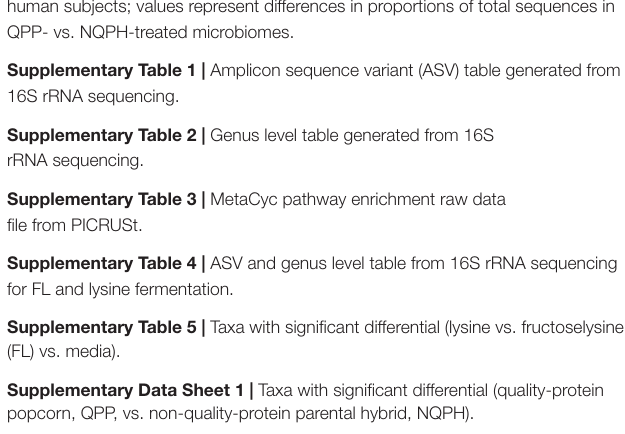
Supplementary Data Sheet 2 | Representative sequences of